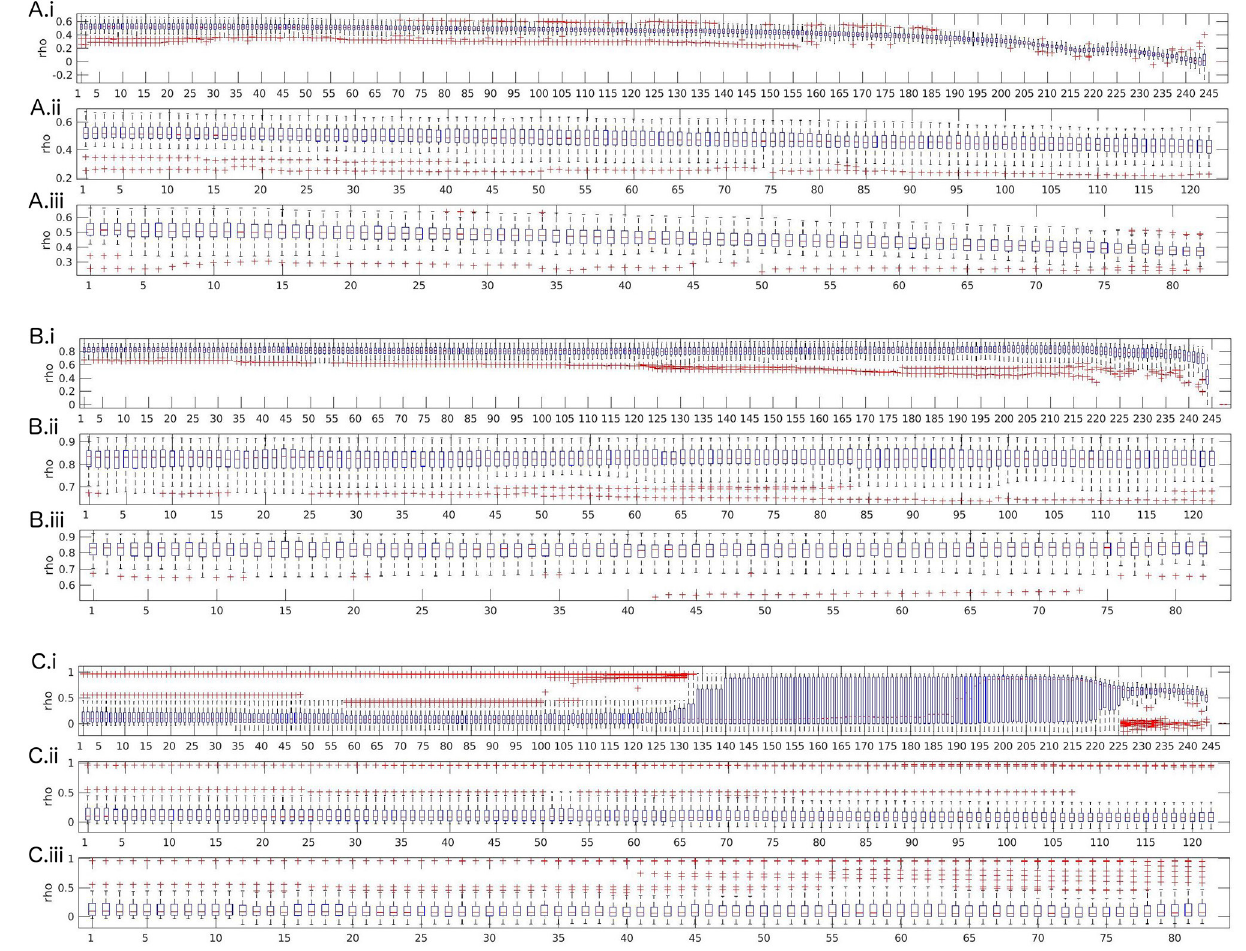
FIGURE 3 | Boxplots of test-retest reliabilities for partial coherence (A) , full frequency directed transfer function (B) , and real-valued coherence (C) . (i) Length variation by successively shortening data by segments of size 500 ms (250 samples). (ii) 0.5 s cut-outs: successively leaving out every second segment of size 500 ms (250 samples). (iii) 1 s cut-outs: successively leaving out every second segment of size 1,000 ms (500 samples). The x-axis represents the number of removed